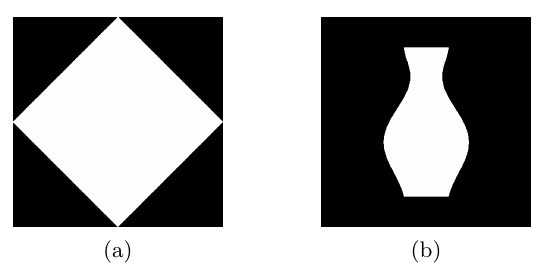
Fig. 12 Masks for the “Phantom”, “Lena”, “Peaks”, and “Vase” datasets. It should be noted that FM and CG-Poisson work only on the Ω represented by the white regions. By contrast, FFT, DCT, and Sylvester work on the whole rectangular domain. (a) The synthetic mask used for “Phantom”, “Lena”, and “Peaks” datasets. (b) Realistic mask for the “Vase”